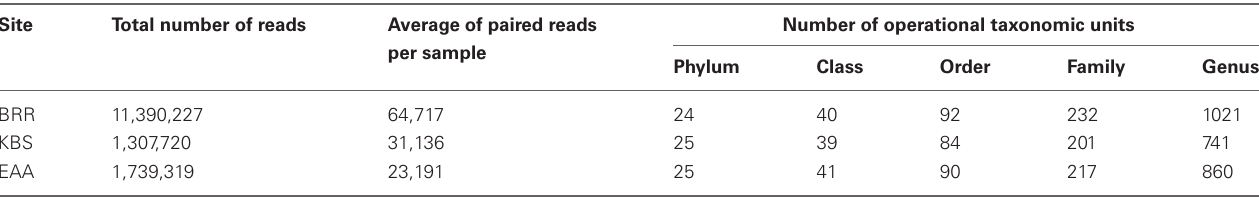
Table 1 | Results of Illumina